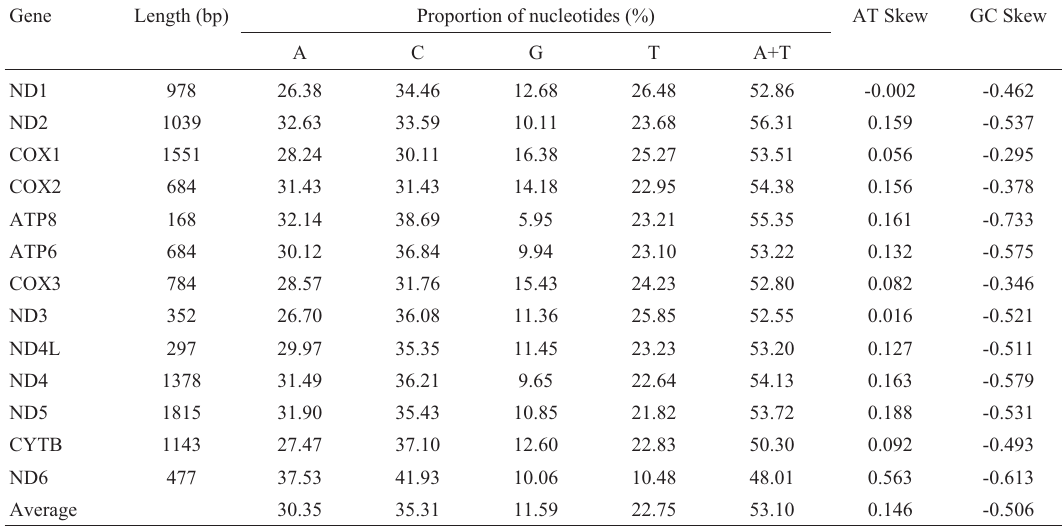
Table 3 - Base composition for protein-coding genes found in mtDNA of E . garzetta .